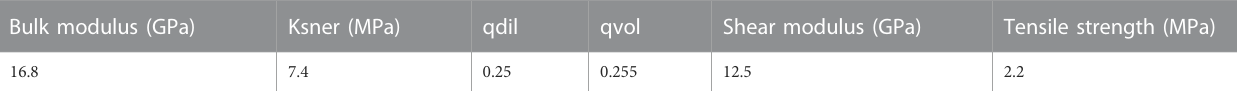
TABLE 3 Material parameters of secondary lining.